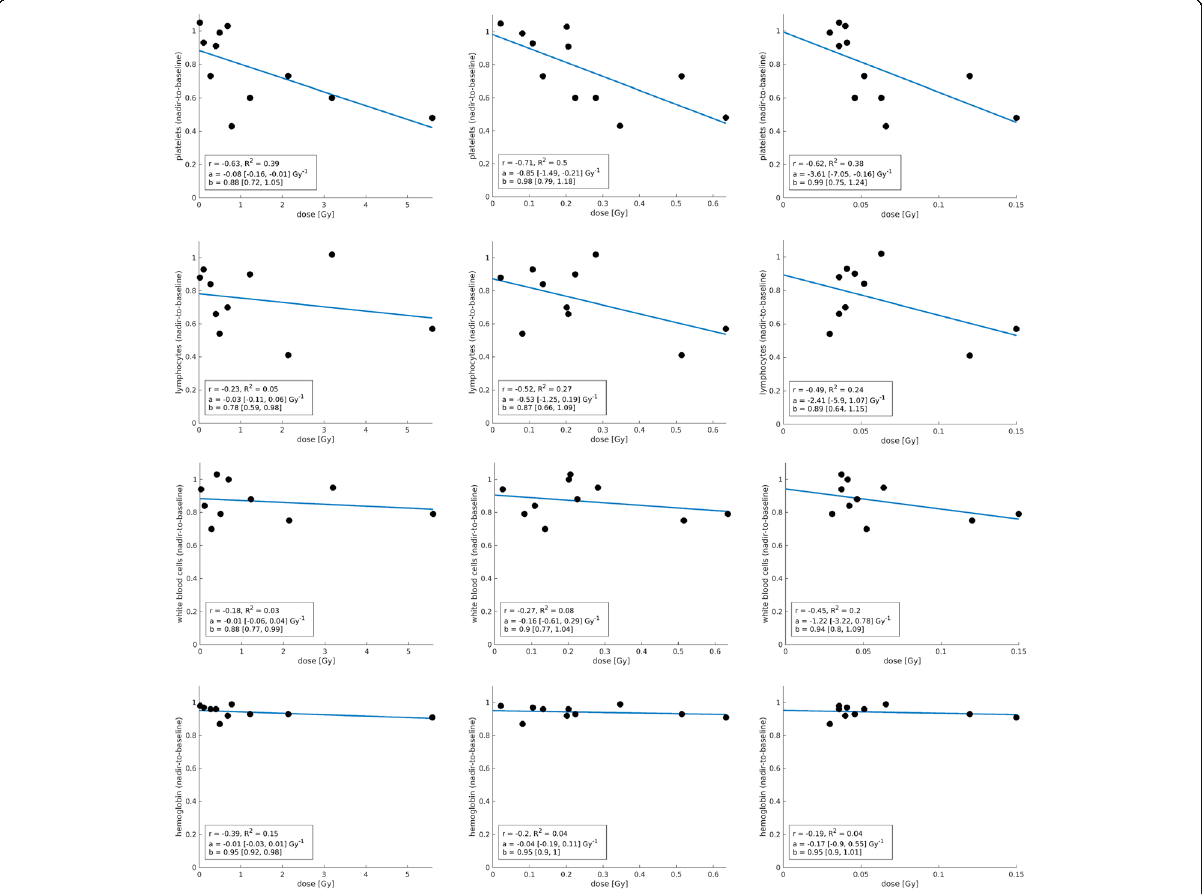
Fig. 2 Results for the correlation analysis between the investigated models for bone marrow absorbed dose calculation and the change of blood element counts (from left to right: MC1, MC2, and SMIRD). Coefficients of the correlation model ( a × x + b ) were indicated, in combination with the 95% confidence bounds